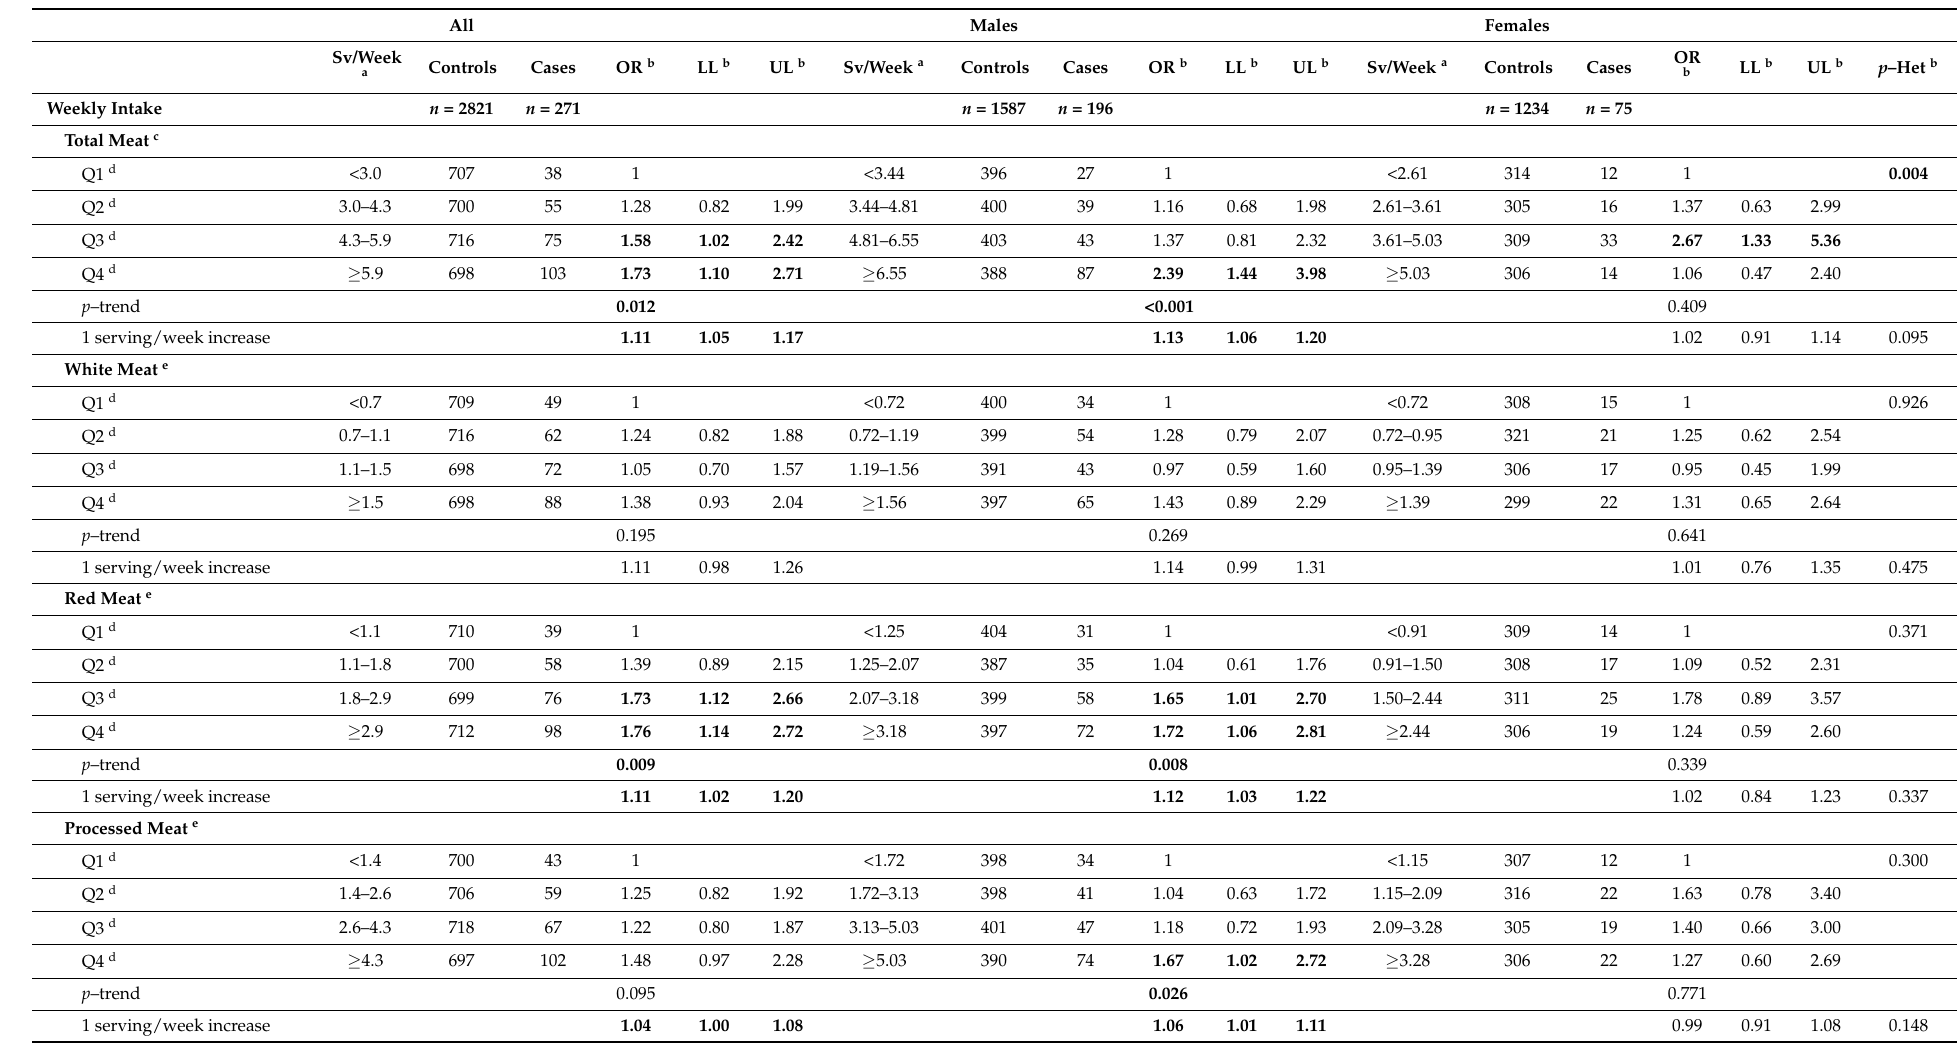
Table 3. Association between gastric adenocarcinoma incidence and total, white, red, and processed meat consumption overall and by sex. All Males